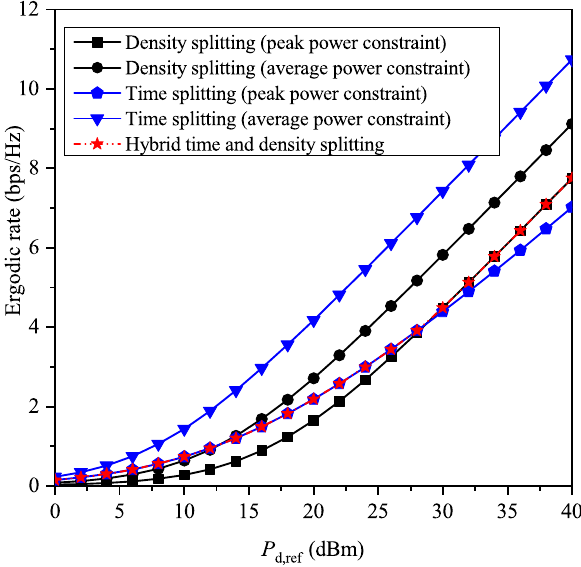
Figure 3. Maximized ergordic rate versus P d,ref for β = 3.